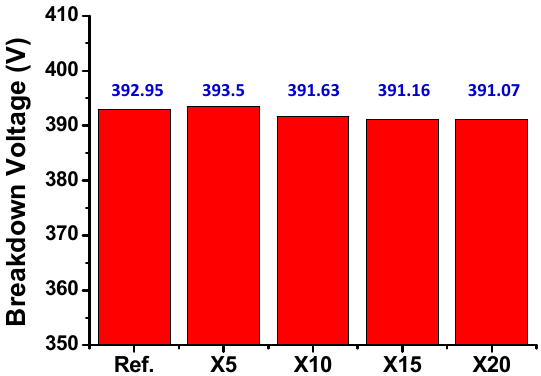
Figure 9. V BK values (shown by the corresponding numbers) comparison of the UHV 300 V GGnLDMOS type-M8 devices with different SJs’ length Xs.